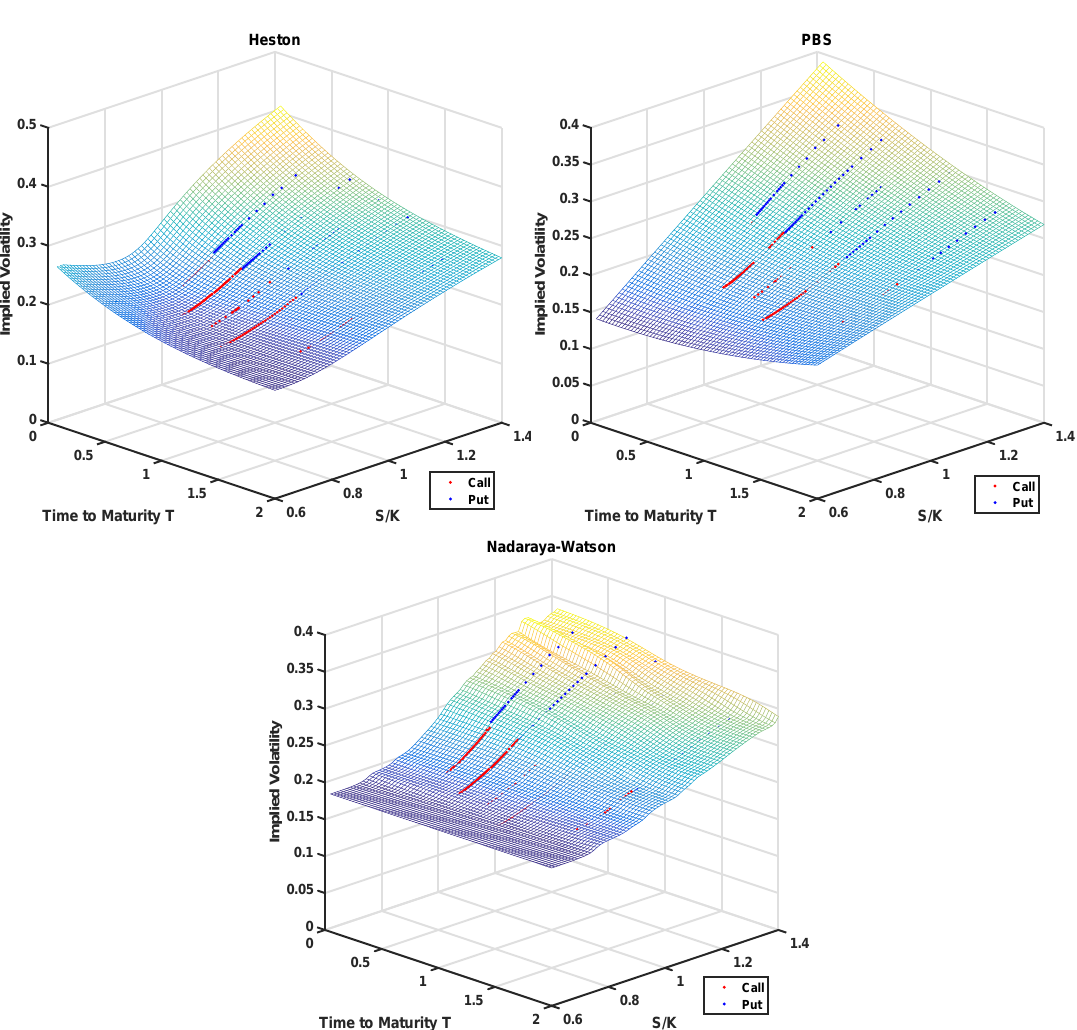
Figure A1. Illustration of Smoothed Implied Volatility Surfaces. Smoothed implied volatility surfaces from Heston, PBS and Nadaraya-Watson on 30 September